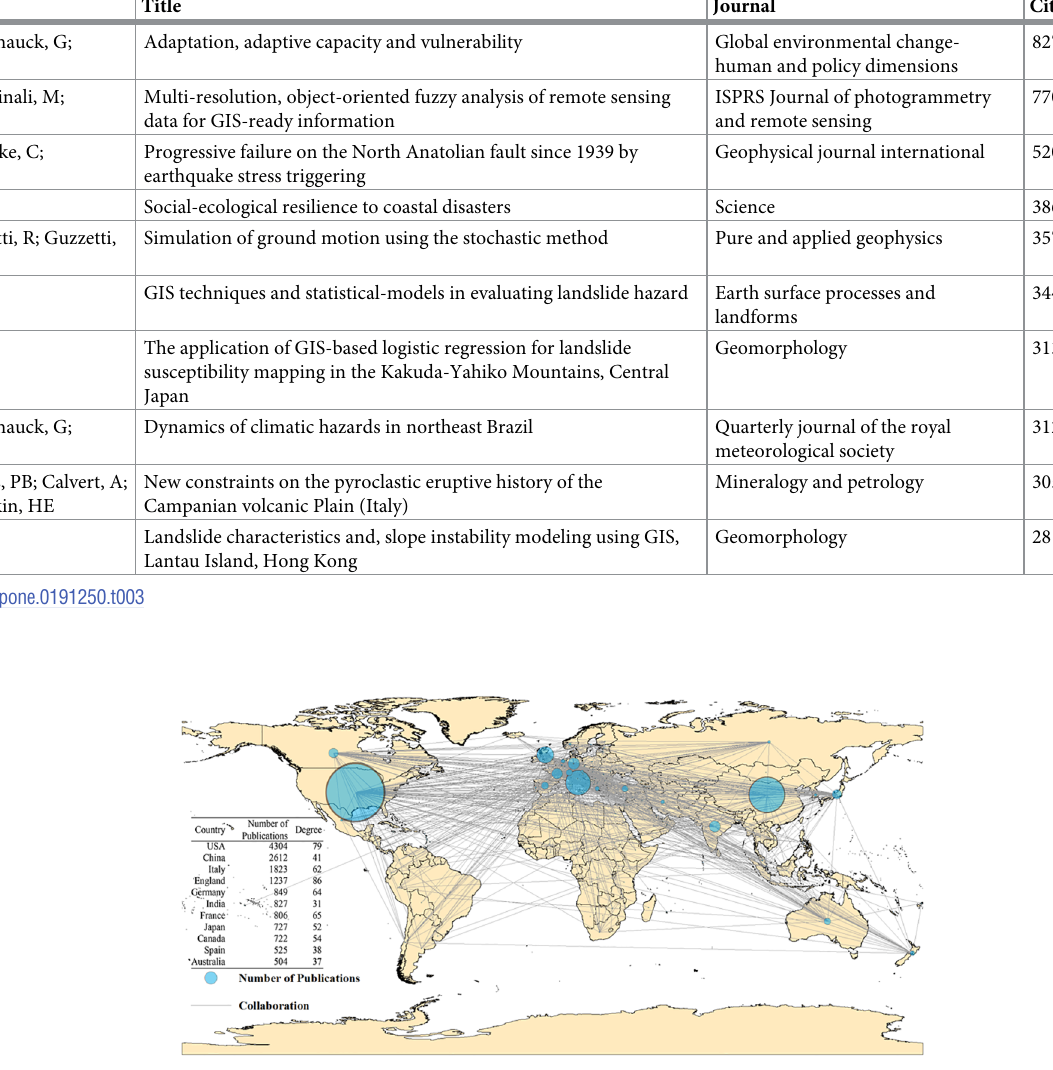
Fig 1. Geographic distribution of collaborating countries. Circular nodes represent countries/regions. The size of a circle is in proportion to the number of literatures of the country. The links of nodes represent cooperating relations between countries or